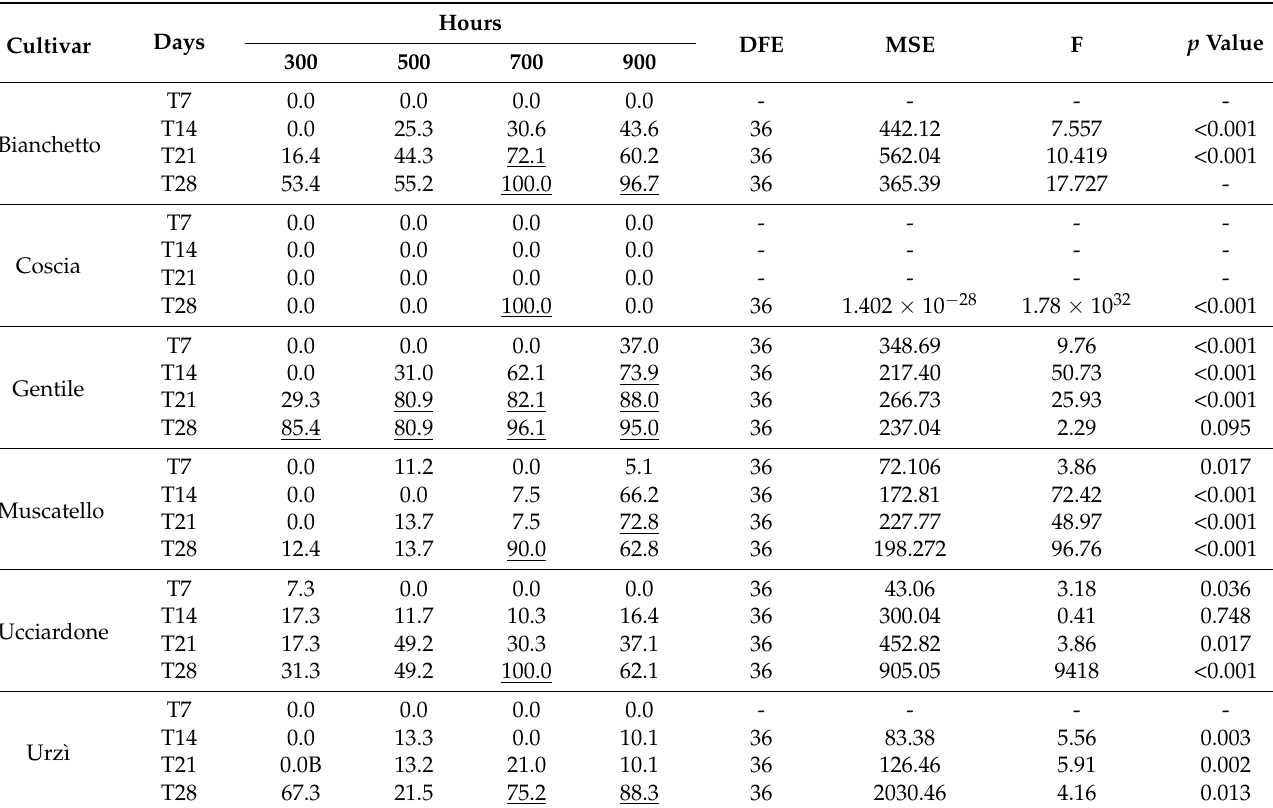
Table 5. Inflorescence emergence rates observed in excised twigs of six early genotypes cultivated in the experimental field 2 (850 m a.s.l.). Excised twigs (one year old) were stored in climatic chamber for 300, 500, 700 and 900 h at +4 ± 0.1 ◦ C followed by 7 (T7), 14 (T14), 21 (T21) and 28 (T28) days at +25 ± 0.1 ◦ C. Degrees of freedom for the error term (DFE), mean square error (MSE), Fisher’s F-test (F), and significance level (Sig.) from one-way ANOVA within cultivars separately for days of storage in climatic chamber at +25 ± 0.1 ◦ C are reported. Inflorescence emergence rates exceeding the 70% (end of endodormancy) are